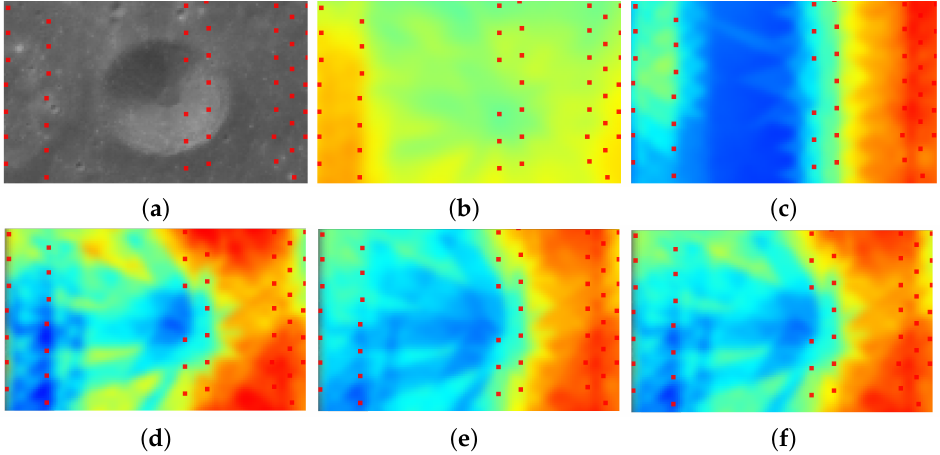
Figure 5. Certainty determination for interpolated data. ( a ) The CCD image containing a crater and LAM data (red dots) captured from Chang’E-1; ( b ) our interpolated altitude map; ( c ) the certainty map measured by the existing method (Equation (16)); ( d ) the cross-checking certainty map (Equation (15)); ( e , f ) the certainty maps measured by our certainty metric with α = 0.5 and α = 0.8, respectively. Note that for altitude maps, the red color indicates high altitude, while the blue color indicates low altitude. Similarly, for certainty maps, the red color indicates high certainty, while the blue color indicates low certainty. These rules are applicable for all figures in this